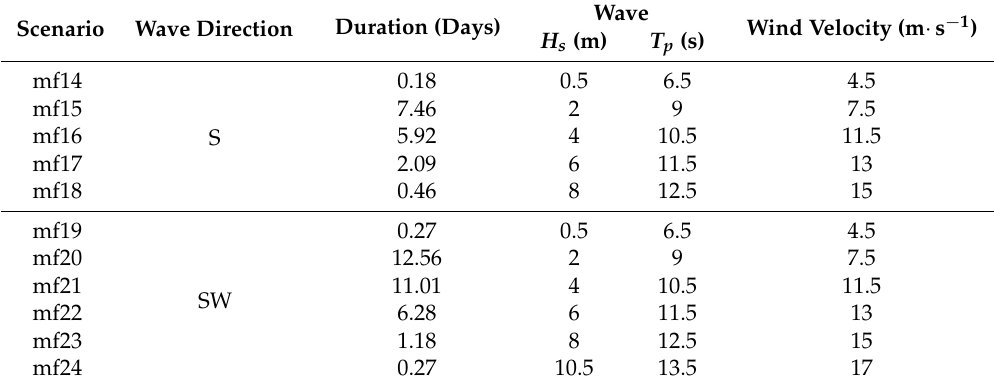
Table 2. Scenario simulations in the flood season (September to